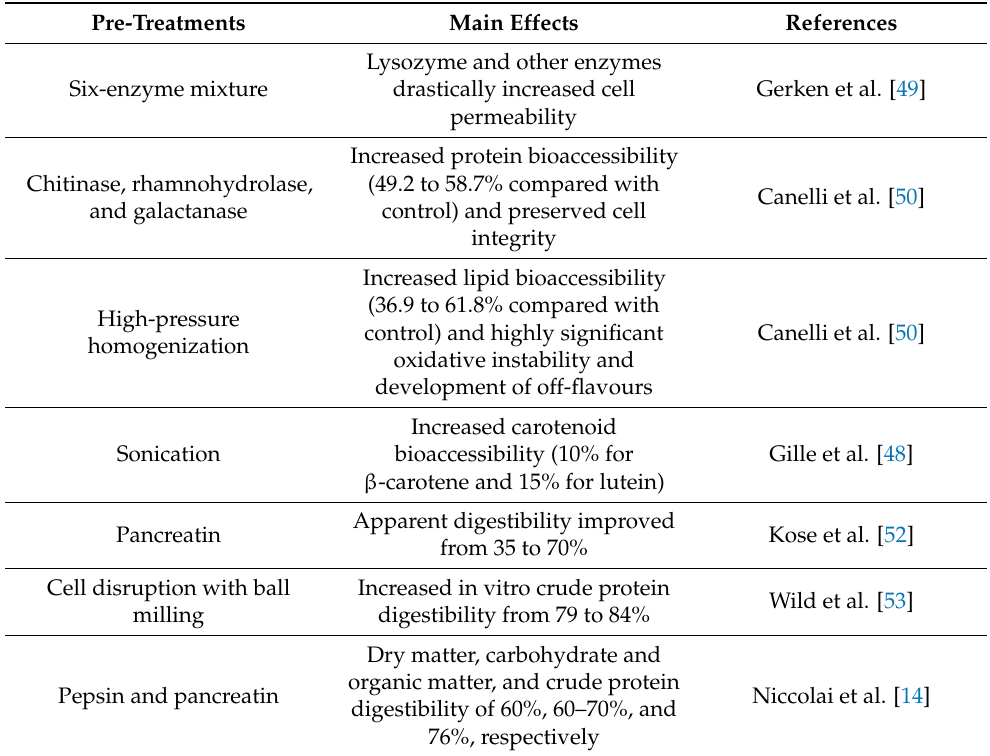
Table 2. Summary of the main effects of in vitro pre-treatments on hydrolysis and digestibility of Chlorella vulgaris